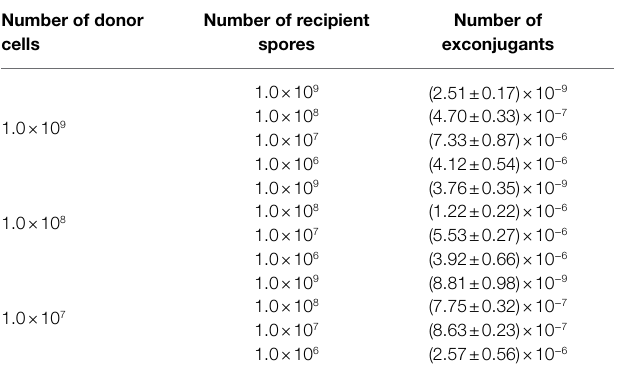
TABLE 1 | Effects of the donor ( E. coli cells)-to-recipient ( P. alni Shahu spores) ratio on transconjugation efficiency. At ratio, three independent conjugations were